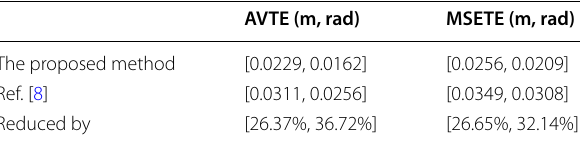
Table 7 Experimental data in 0.3 m/s ocean current environment